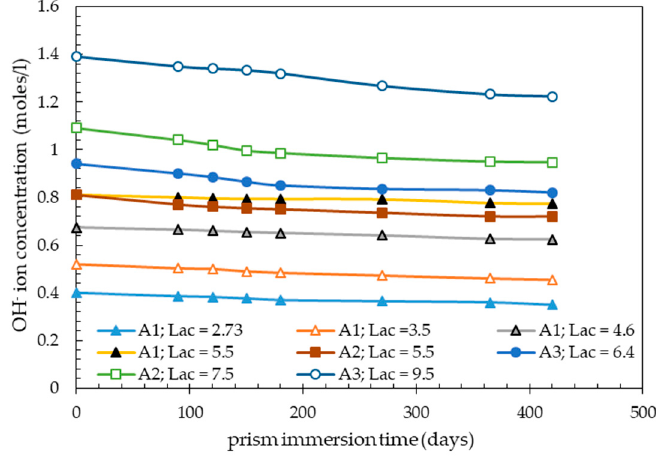
Figure 1. Changes in the OH − ion concentration of alkaline solutions during the accelerated CPT.